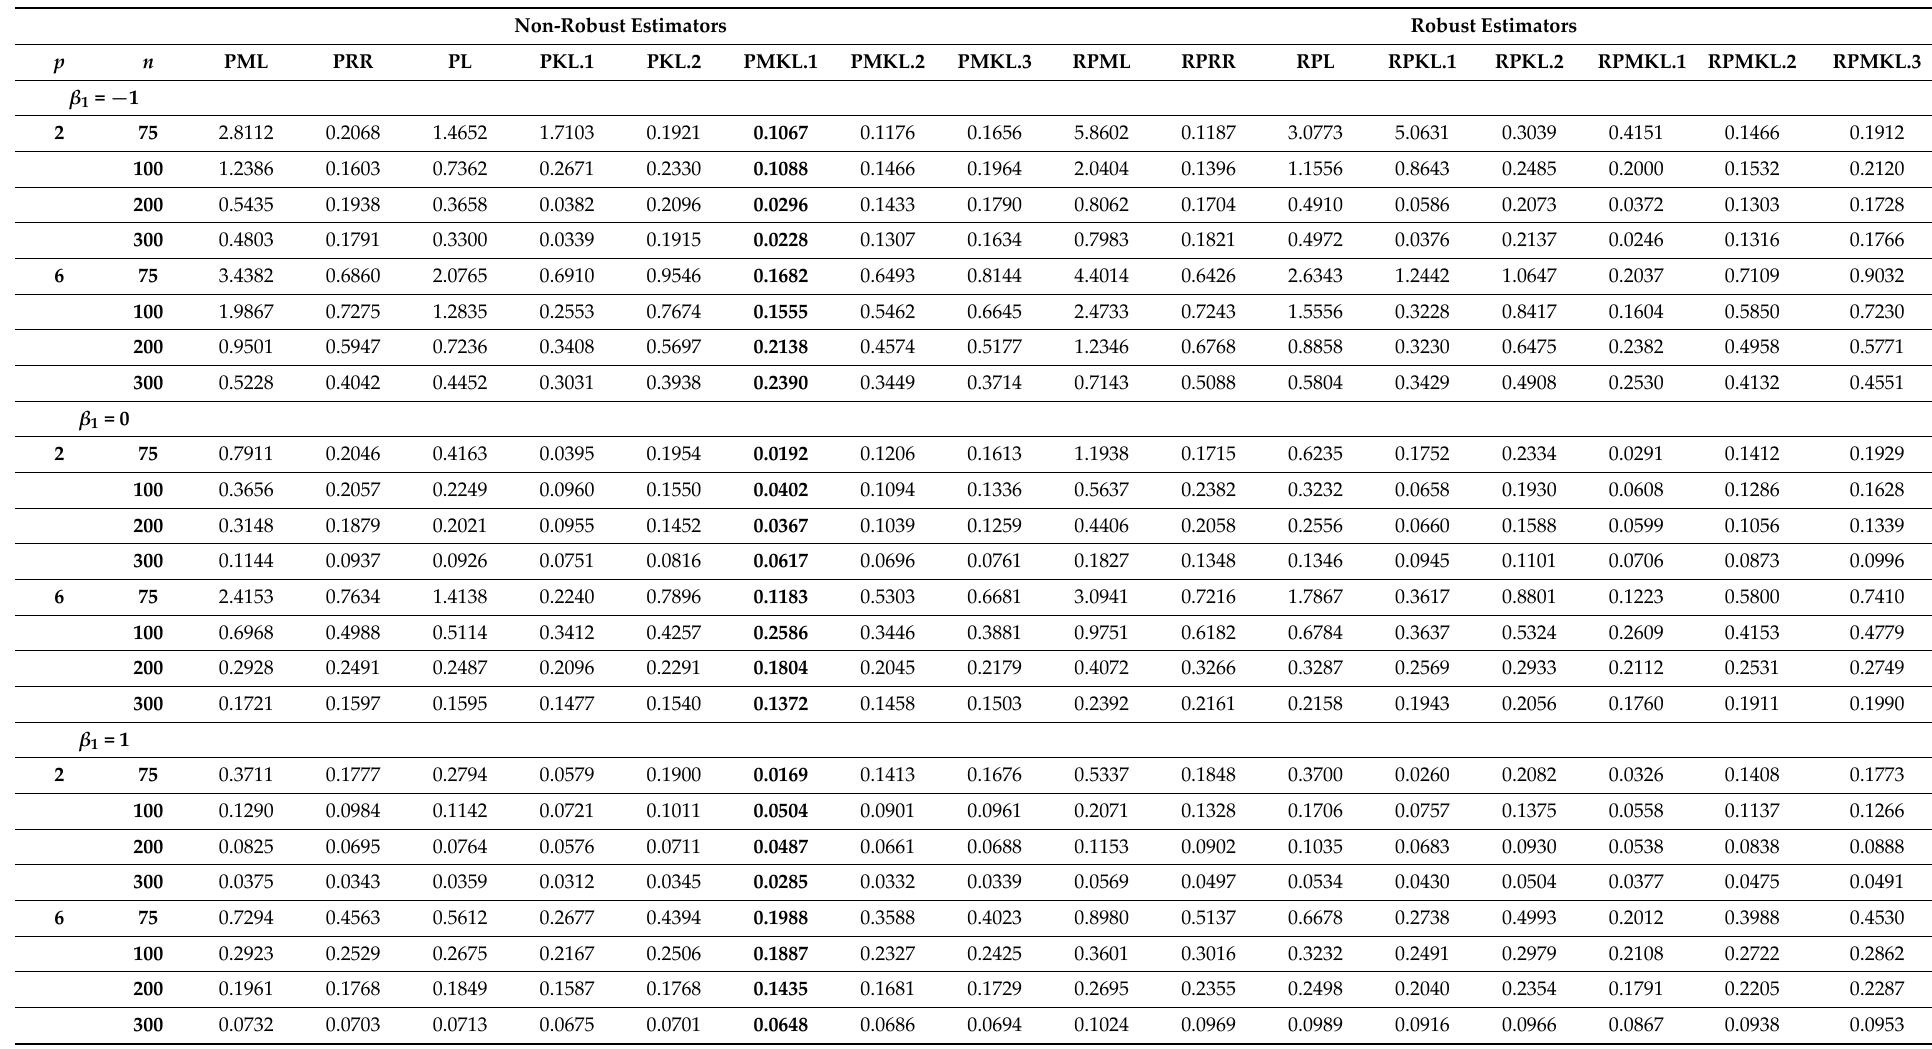
Table A3. AMSE of different estimators when τ = 0% and ρ =